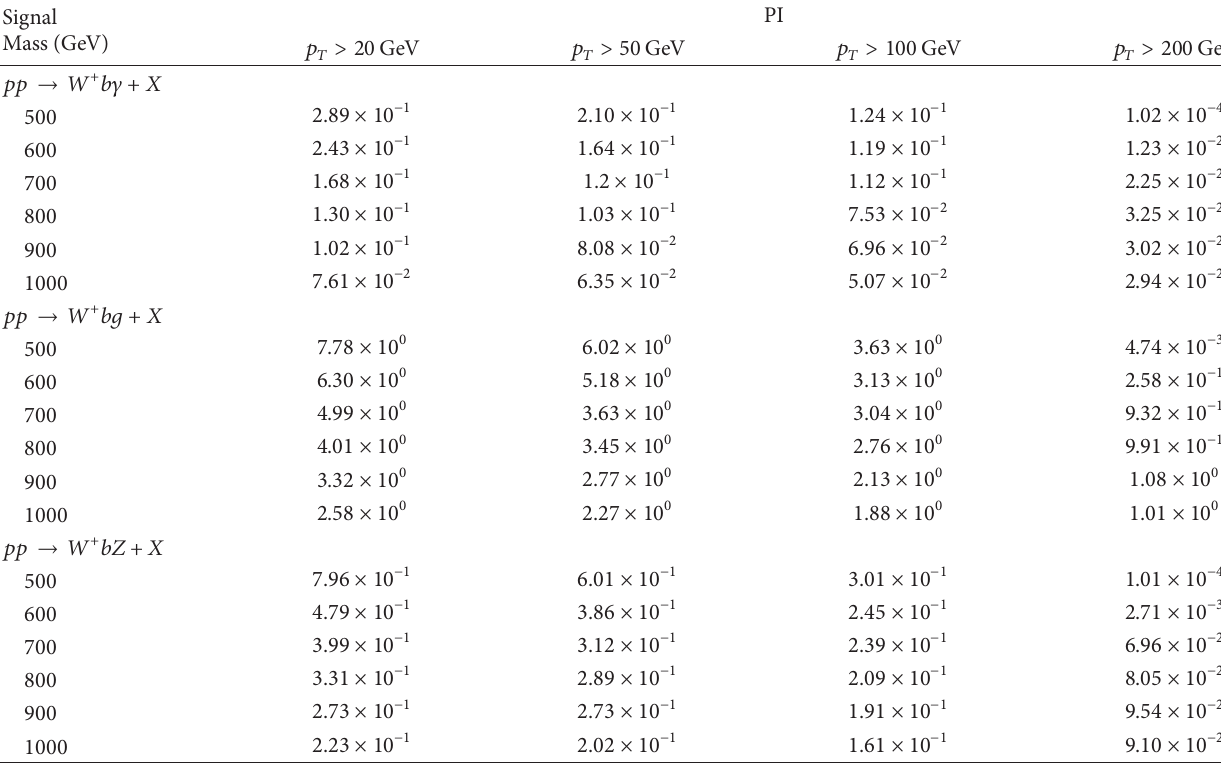
Table 7: The cross sections (in pb) for 𝑡 󸀠 signal in different decay channels for PI parametrization with 𝑝 𝑇 cuts on the jets and photon and | < 2.5 at the center of mass energy √𝑠 = 13 |𝜂 𝑗,𝛾